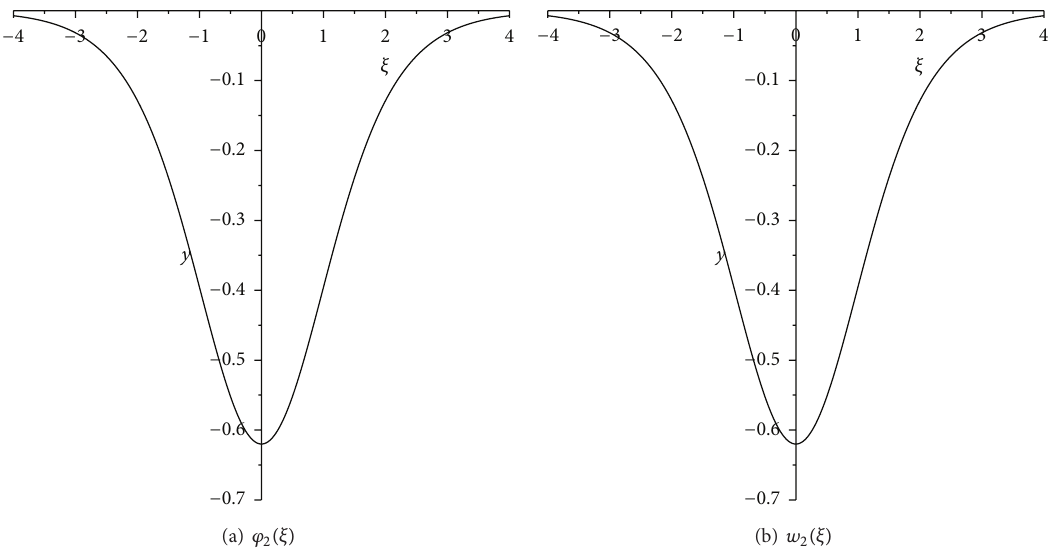
Figure 5: The solitary wave of the system (11) and the system (3) when −4√3𝑘𝑐/3 < 𝑟 < −2√𝑘𝑐 , 𝑘 > 0 , 𝑐 > 0 , and Δ ≥ 0 .